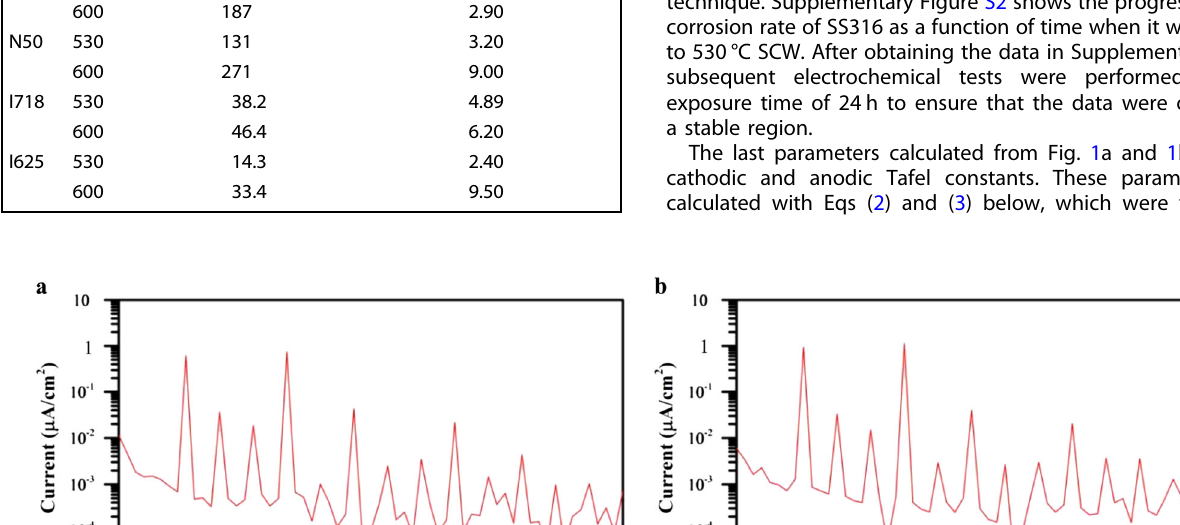
Table 1. Summary of corrosion rate values for gravimetric studies: Corrosion rates for SS316, N50, I718 and I625 in supercritical and ultra- supercritical water for gravimetric studies Alloy Temperature (° C)